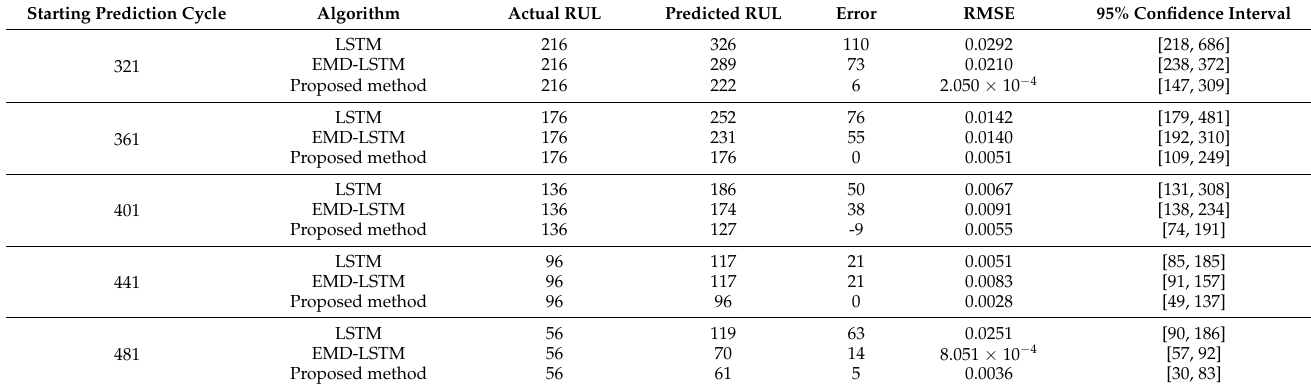
Table 3. Comparison of error results of four algorithms based on